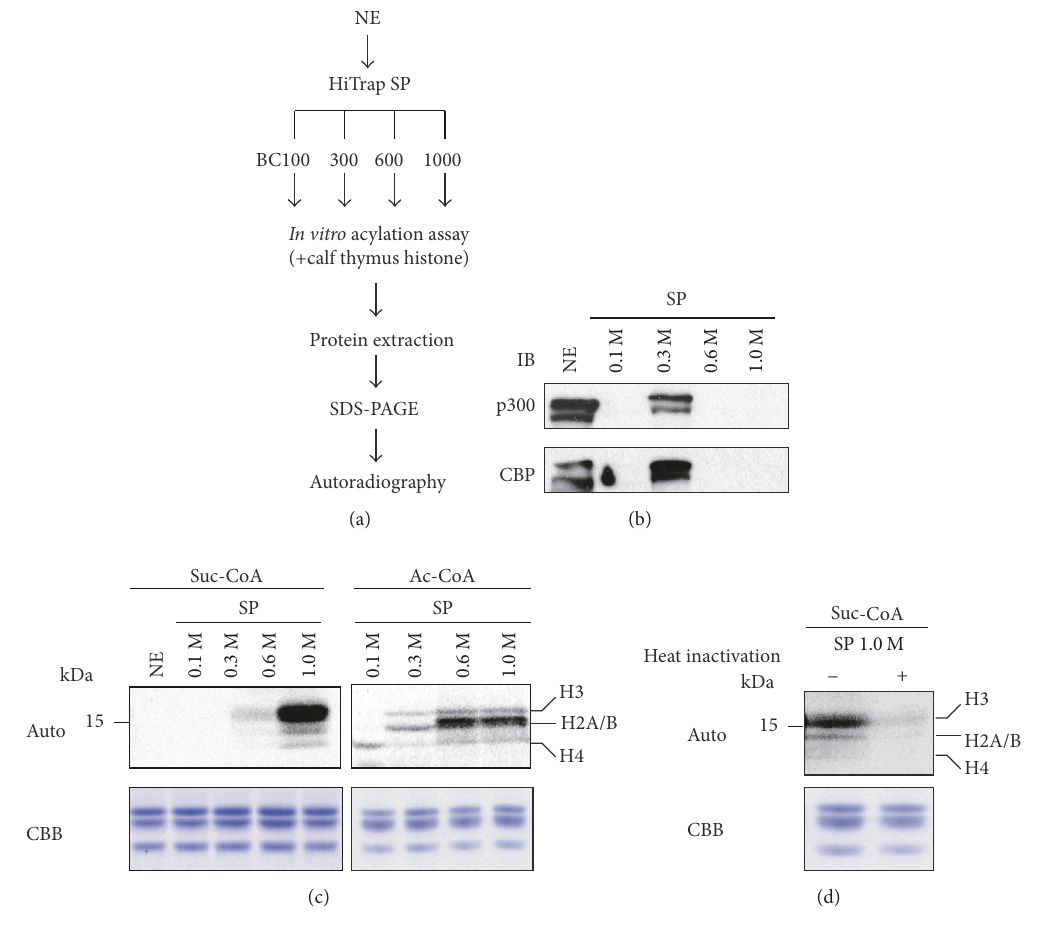
Figure 3: In vitro histone acylation assays using strong cation exchange column-fractionated HepG2 nuclear extracts. (a) Schematic diagram ofthefractionationofHepG2nuclearextracts(NEs).HepG2NEswereloadedontheHiTrapSPcolumnandelutedwithBCbufferscontaining the indicated KCl concentration. Each eluted protein was used for the in vitro acylation reaction. (b) Validation of HepG2 cell nuclear extracts fractionationbystrongcationexchangecolumn.Nuclearextract(NE)inputandeachelutedfraction(0.1,0.3,0.6,and1.0 MKCl)wereassessed by western blotting using anti-p300 and anti-CBP as first antibodies. (c) 14 C-labeled coenzyme A incorporation into histone proteins was assessed by autoradiography. The amounts of added substrate (calf thymus histone proteins) in each reaction were visualized by Coomassie Brilliant Blue (CBB). Molecular weight is indicated on the left side of the figure, and each histone position (histones H3, H2A/B, and H4) is indicated in the right side of the figure. (d) The effect of heat inactivation was assessed. The SP 1.0M fraction of nuclear extracts was heat- inactivated at 96 ∘ C for 10min. The amounts of added substrate (calf thymus histone proteins) in each reaction were visualized by Coomassie Brilliant Blue (CBB). Molecular weight is indicated on the left side of the figure, and each histone position (histones H3, H2A/B, and H4) is indicated in the right side of the figure. SP: HiTrap SP